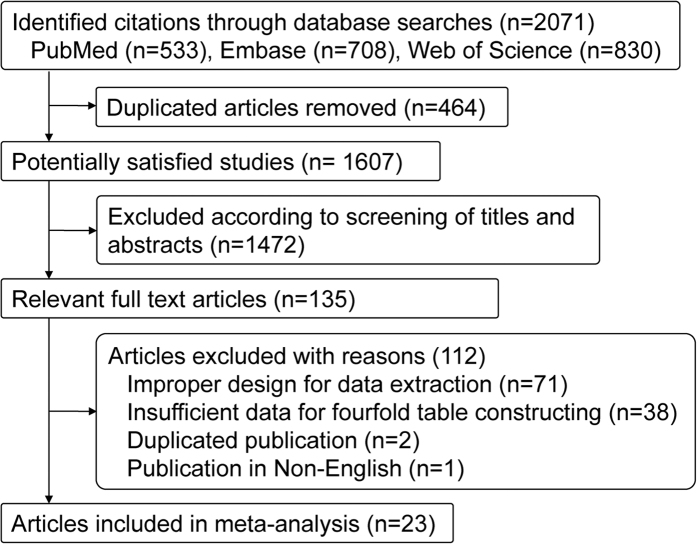
Study flow chart.